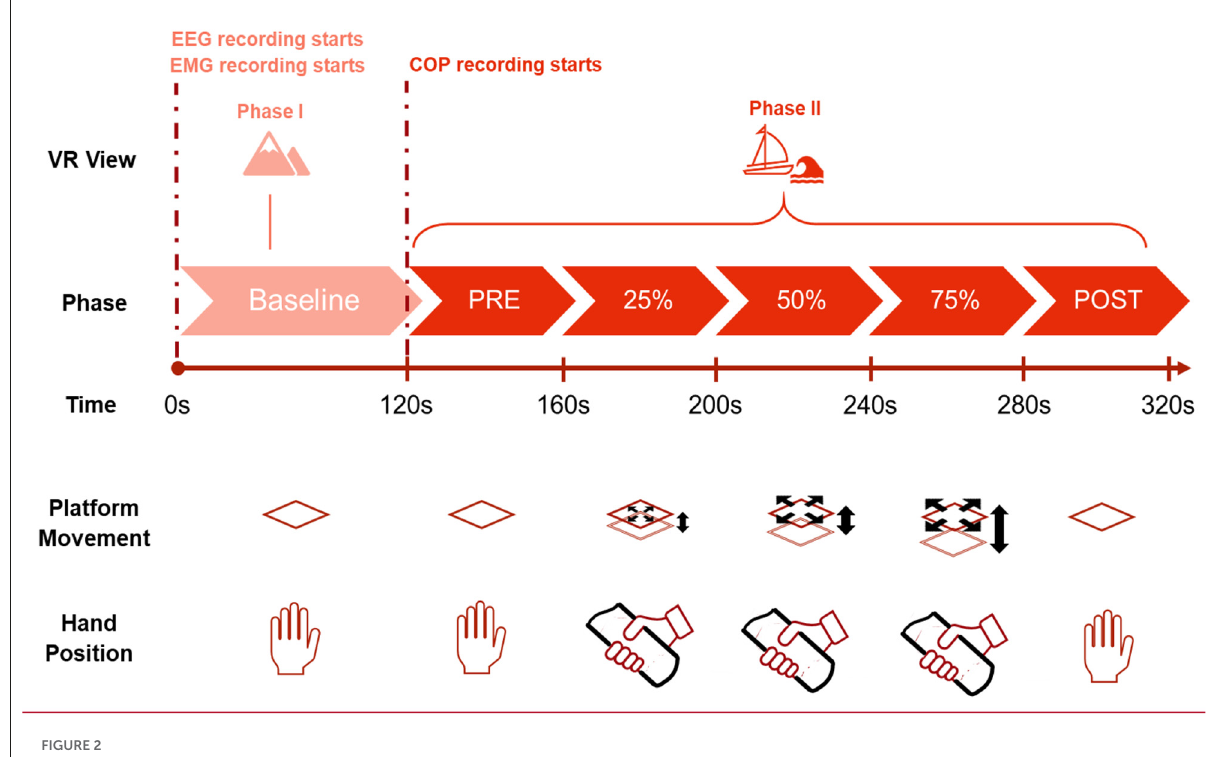
FIGURE2 Different phases of the